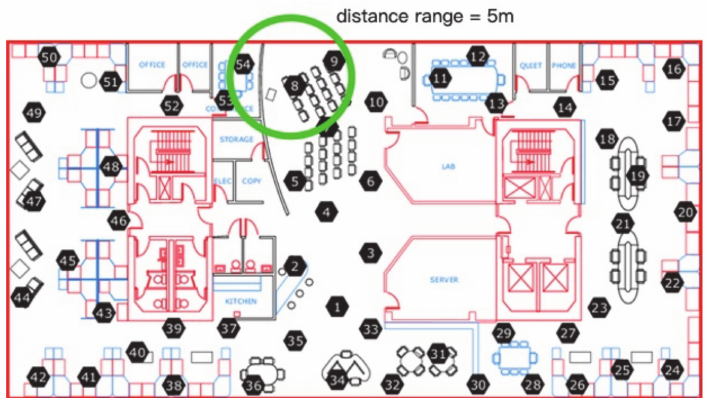
Figure 3. The example of a neighbor group affected by walls in Intel Lab dataset.